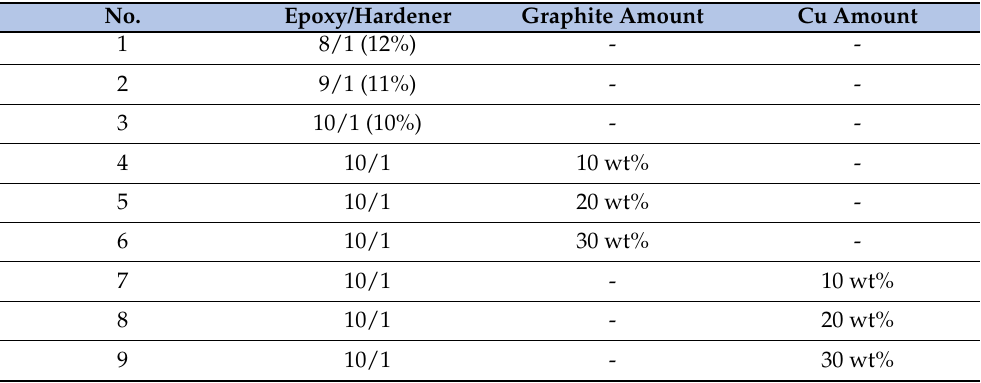
Figure 2. Process for the Test of Shape Memory Sample Preparation. Table 1. Composite mixing